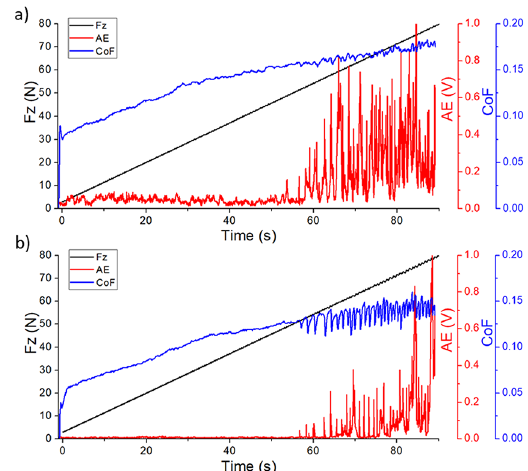
Figure 8. Results of scratch test carried out on DLC-1 and DLC-2 coatings. Fz (black), AE (red) and CoF (blue) signals are indicated. (a) DLC-1 coating starts failing at a 49 N Lc1 critical load. (b) DLC-2 coating starts failing at a 52 N Lc1 critical load for the formation of the first cracks. CoF varies from 0.08 to 0.15.